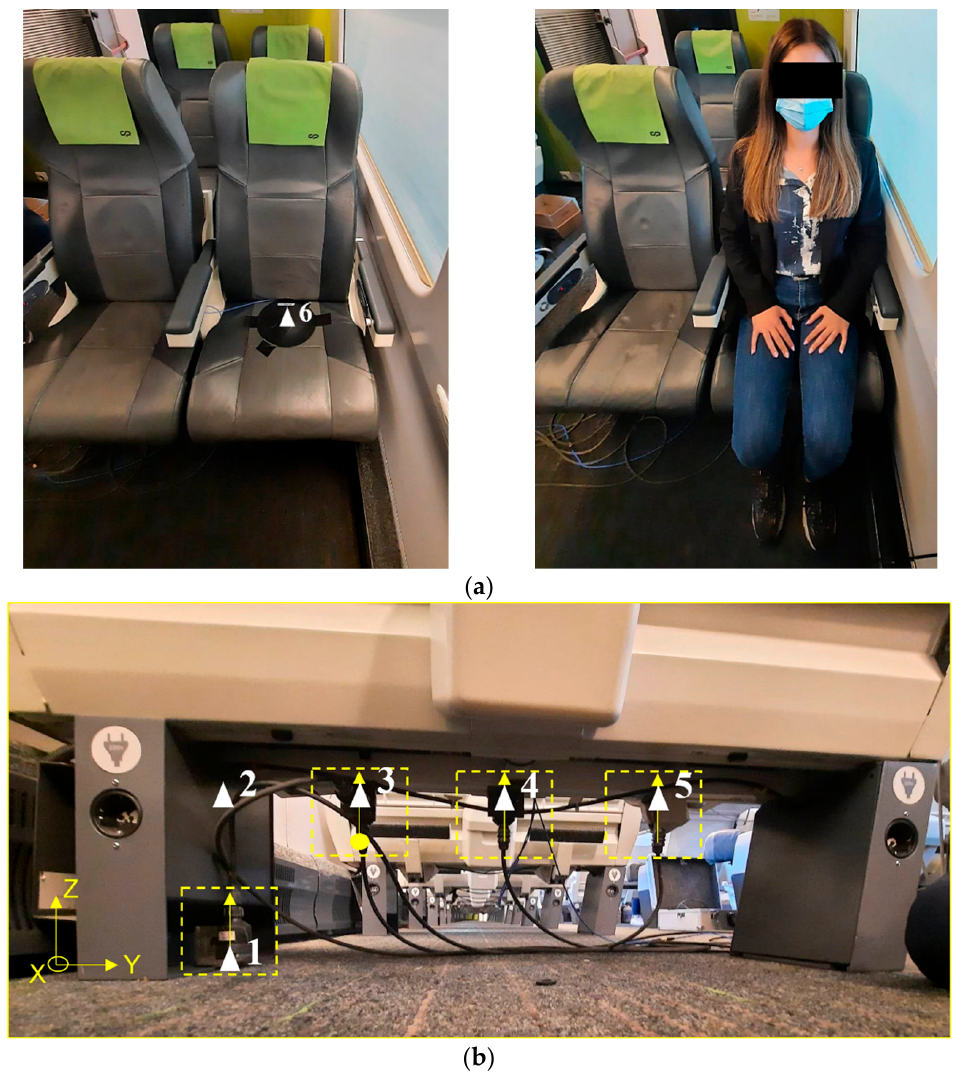
Figure 6. Experimental test setup: ( a ) seat pad location and experimental test; ( b ) accelerometers distribution along seat frame structure. Each number represents the modal node used on ARTeMIS software (see Section 3.2.2).